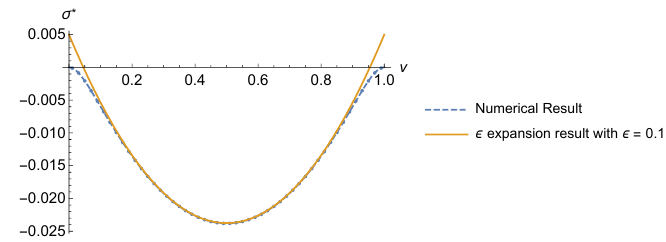
Figure 2. Saddle point value of σ ∗ in d = 3 . 9 critical theory with ∆ + boundary condition at leading order in large N . Dashed line represents smooth interpolation of the numerical result. For comparison, we also plot the analytic result in d = 4 − (cid:15) at (cid:15) = 0 . 1 .